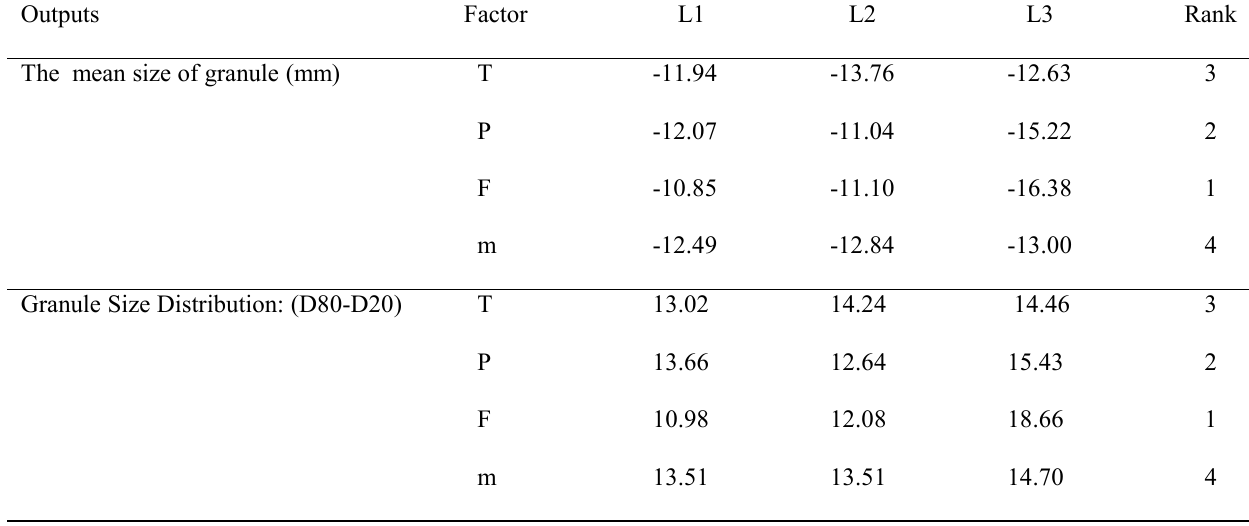
Column assignment for the S/N ratios of various outputs onto different levels.